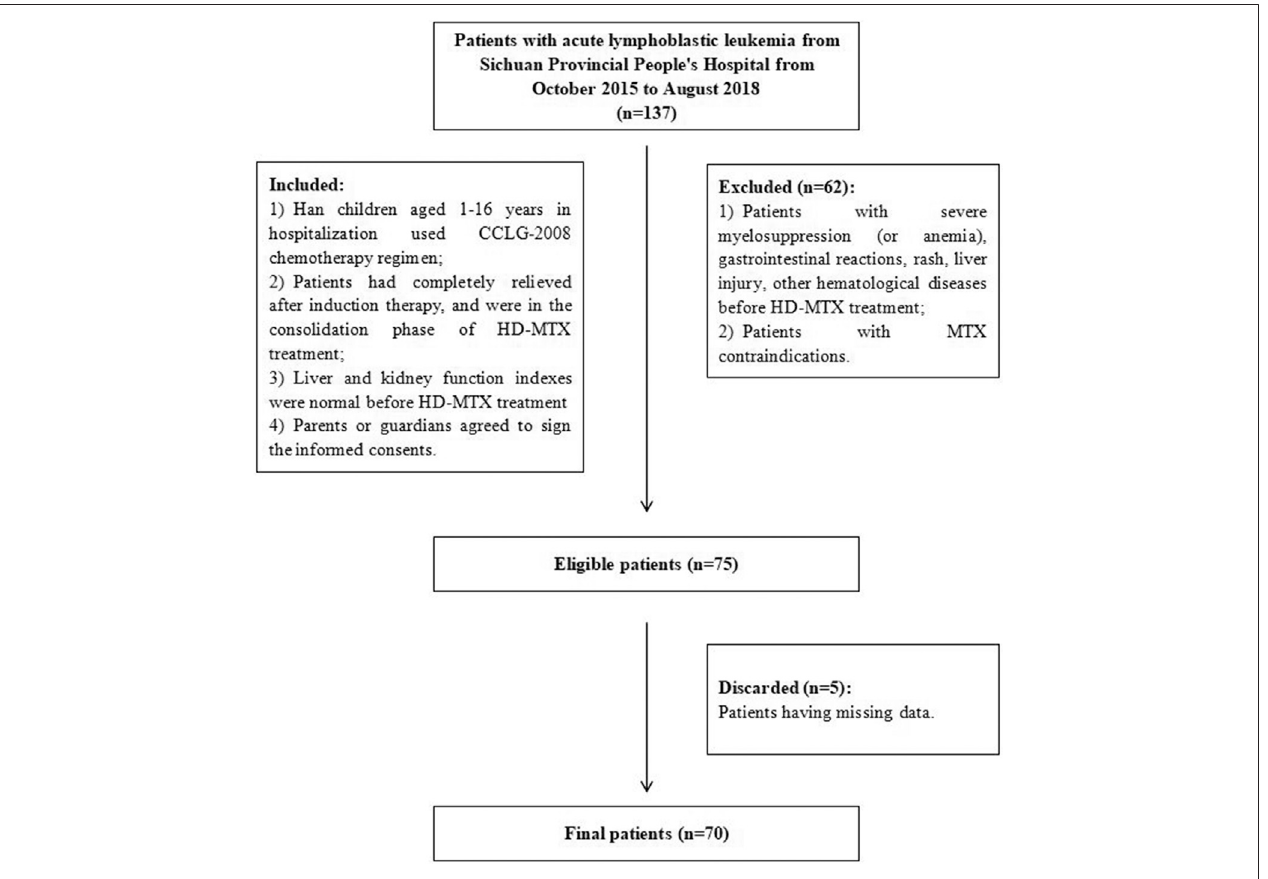
FIGURE 2 | Flowchart of patient inclusion. Abbreviations: CCLG-2008, Chinese Children ’ s Leukemia Group-2008 protocols; MTX, methotrexate; HD-MTX, high- dose methotrexate.